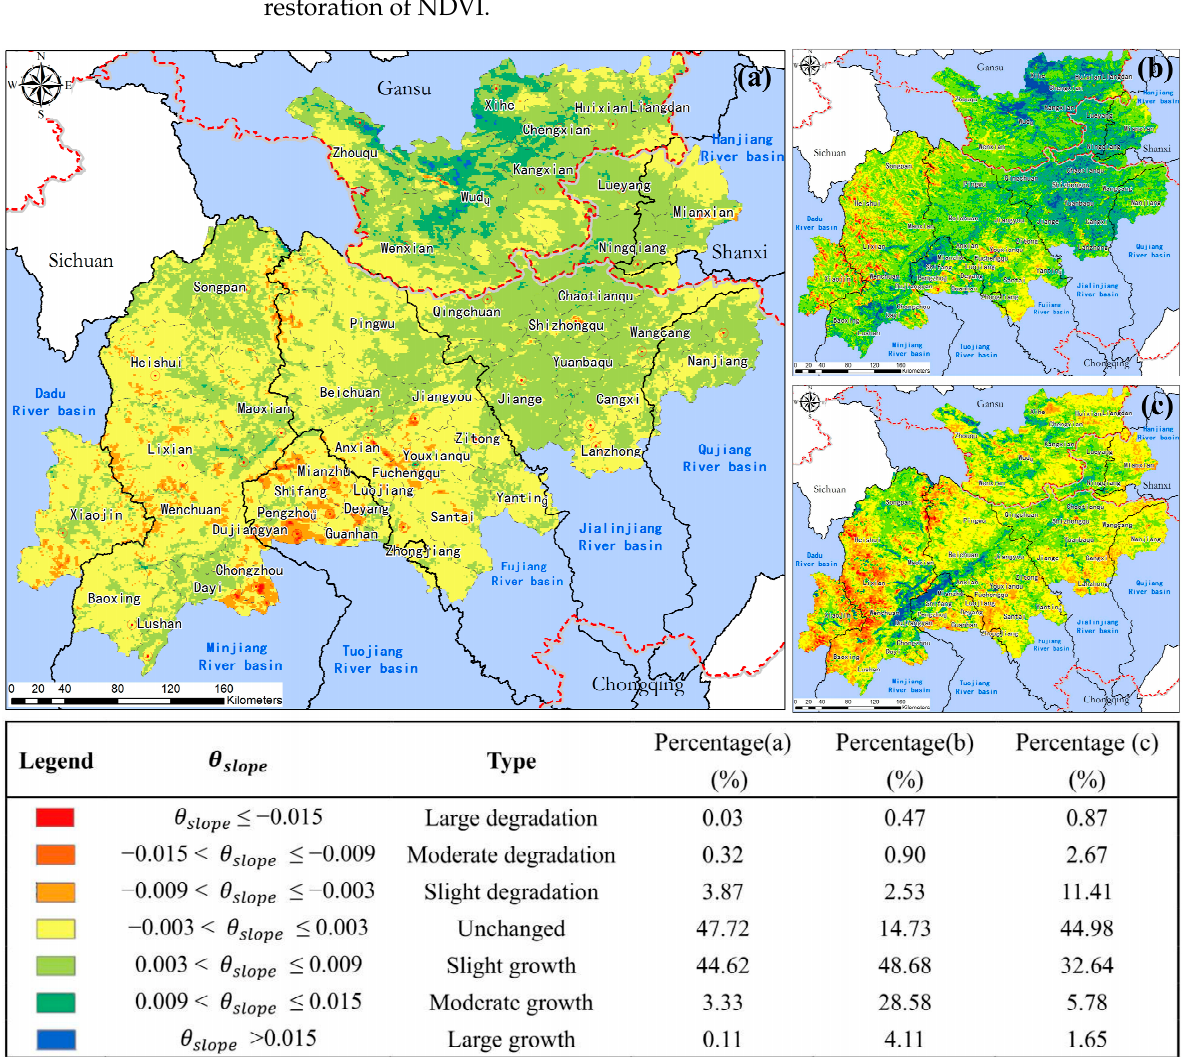
Figure 6. Spatial distribution of changes in the slope ( θ slope ) of NDVI ( a ) from 1999 to 2018, ( b ) 1999 to 2007, and ( c ) 2009 to 2018.